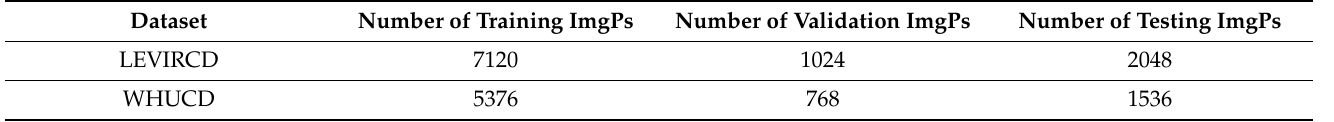
Figure 1. Examples of multi-date images from the LEVIRCD dataset. Newly constructed buildings are shown from ( a – d ). A demolished building is shown in ( e ). ( f ) displays unchanged regions with different colors. Table 1. An overview of multi-date image pairs (ImgPs) with 256 × 256 pixels in LEVIRCD and WHUCD datasets.